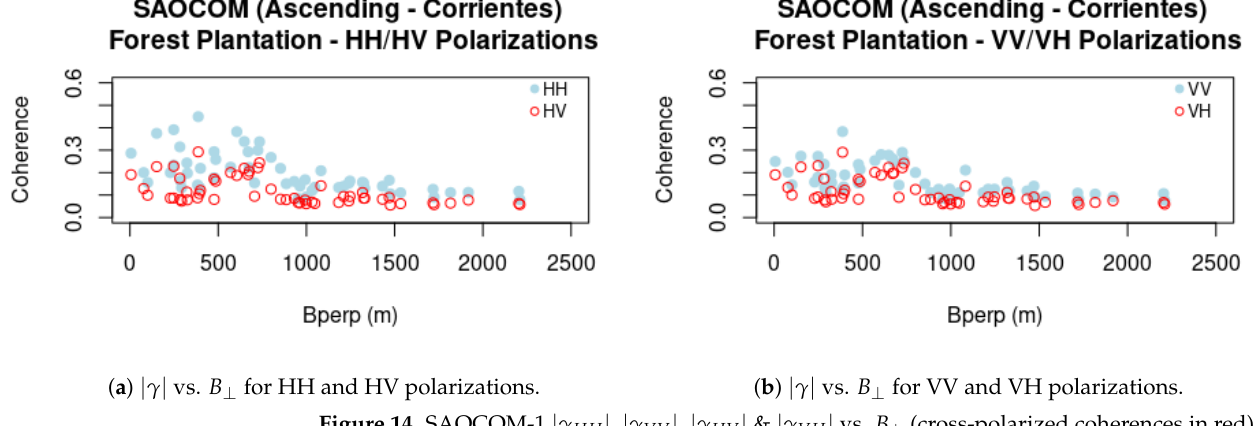
Figure 14. SAOCOM-1 | γ HH | , | γ VV | , | γ HV | & | γ VH | vs. B ⊥ (cross-polarized coherences in red).